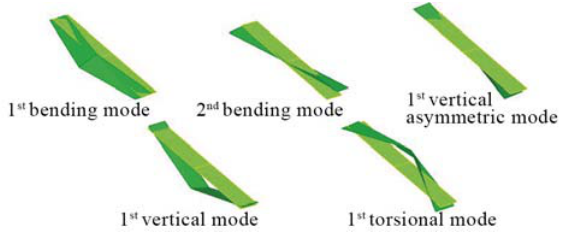
Fig. 9. Experimentally identified the 5 five mode shapes Table 2. Comparison of analytically and experimentally identified dynamic characteristics Analytical No. Frequencies, Hz